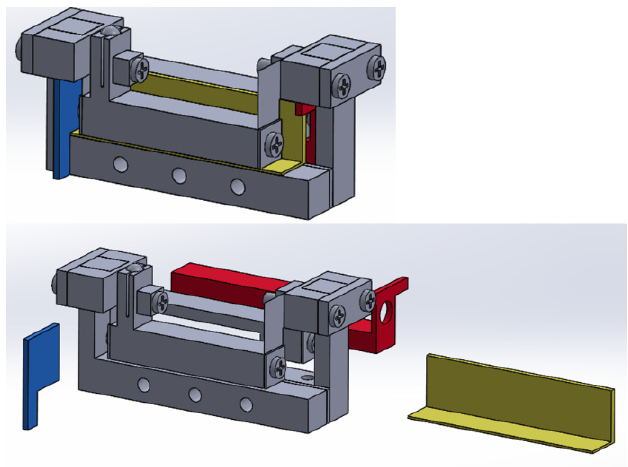
Figure 23. Fixtures for the assembly of the compact model.